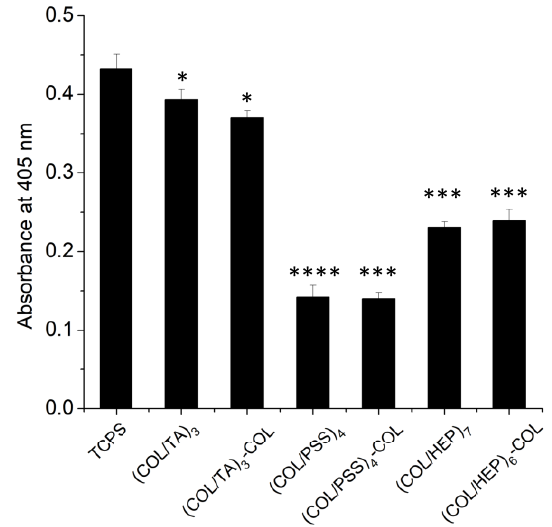
Figure 4. Cytotoxicity of the COL-based films towards human fibroblast cells. Acidic phosphatase assay of cells incubated for 22 h on different COL-based films and tissue culture polystyrene. The data represent the mean and standard deviation of the experiments conducted in triplicate. The two-tail Student’s t -test was calculated on the absorbance values of individual experiments in comparison to the TCPS (* p ≤ 0.05, *** p ≤ 0.001, and **** p ≤ 0.0001). COL/PSS (0.140 ± 0.011) and COL/HEP (0.235 ± 0.011) films led to